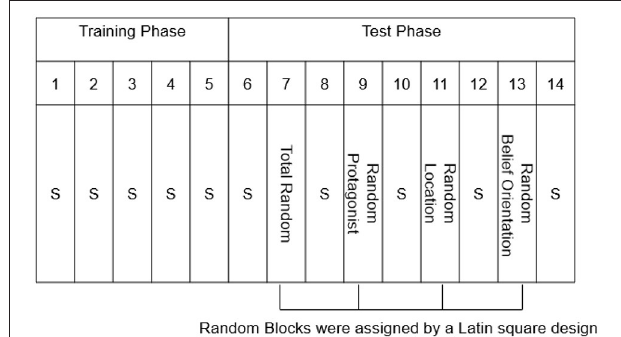
FIGURE 5 | The procedure of Experiment 2 with Blocks numbered 1–14. S = Standard Blocks (with fixed belief-related sequence). Note that every block has a length of 48 trials. One random sequence was created for all dimensions together (i.e., Total Random), and three pseudo-random sequences were created to test implicit learning of each belief-related dimension (i.e., Random Protagonist, Random Belief Orientation, and Random Location). A total of four different orders created by a Latin square design. After the main experiment shown here, there was a recognition test and a post-check questionnaire to measure awareness of the embedded sequence.